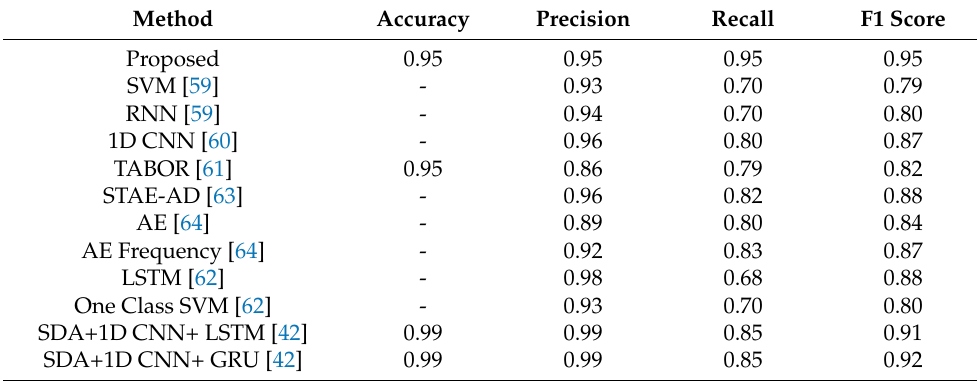
Table 4. Summary of the results and performance comparison on the SWaT